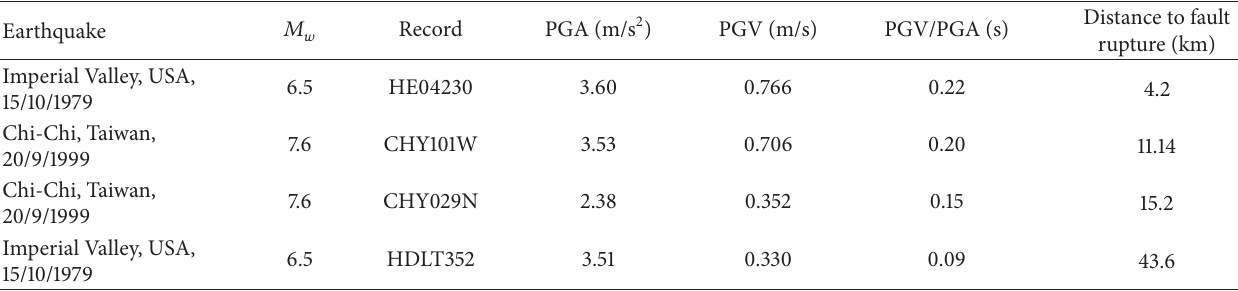
Table 2: Ground motion information.